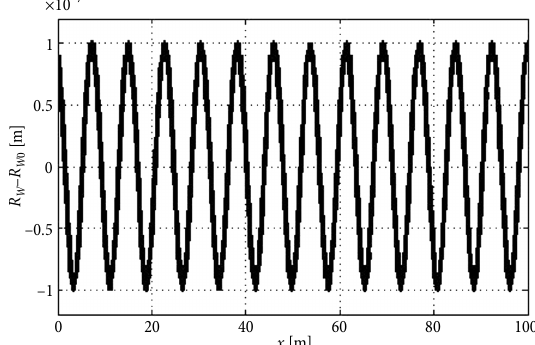
Fig. 9. A deviation of wheel radius from the nominal radius under the flat length of L F = 100